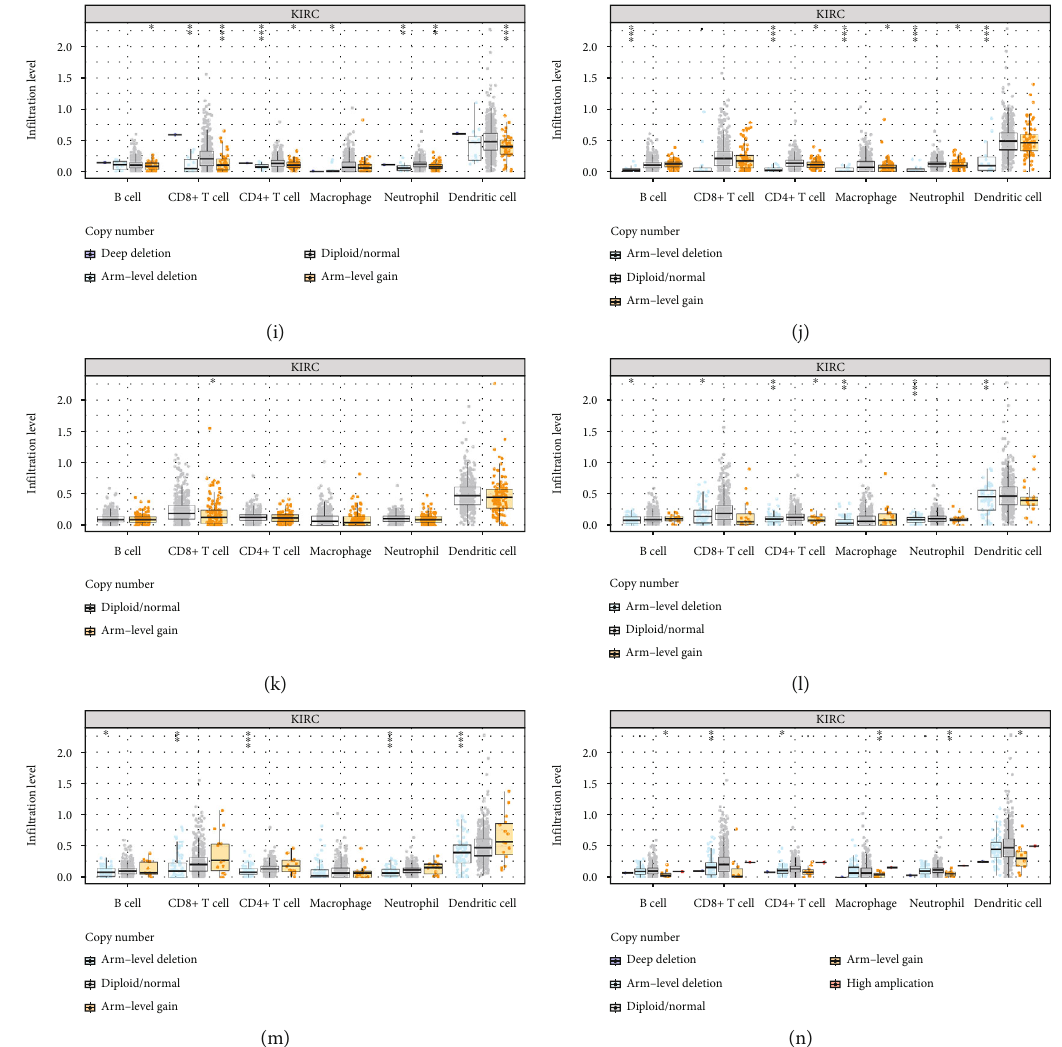
Figure 4: Correlations between CNV and immune cell in fi ltrations of twelve m 5 C modi fi cation regulators in ccRCC. (a) The copy number variation (CNV) frequency percentage of m 5 C regulators in ccRCC. The red dot represents the CNV ampli fi cation, and the green dot represents the CNV deletion. (b) The location of CNV of m 5 C regulators on chromosomes. (c – n) Correlation analysis between the CNV of m 5 C-related signature and immune cell in fi ltration. (c) NOP2. (d) NSUN2. (e) NSUN3. (f) NSUN4. (g) NSUN5. (h) NSUN7. (i) DNMT1. (j) DNMT3A. (k) DNMT3B. (l) TRDMT1. (m) ALYREF. (n) TET2. ∗ p < 0 : 05 , ∗∗ p < 0 : 01 , and ∗∗∗ p < 0 : 001 . ns: no signi fi